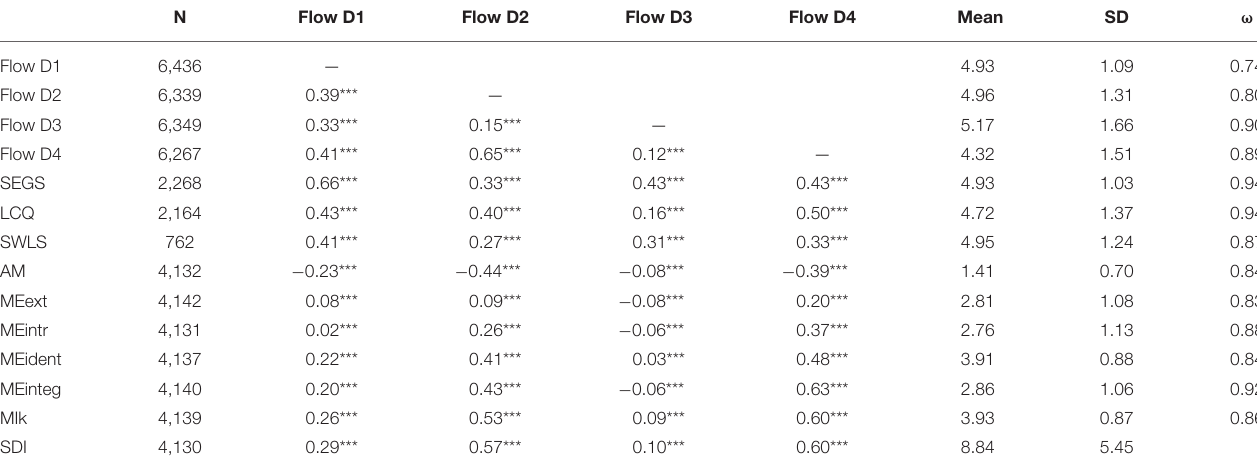
TABLE 3 | Correlations between flow dimensions and measurement scales and descriptive